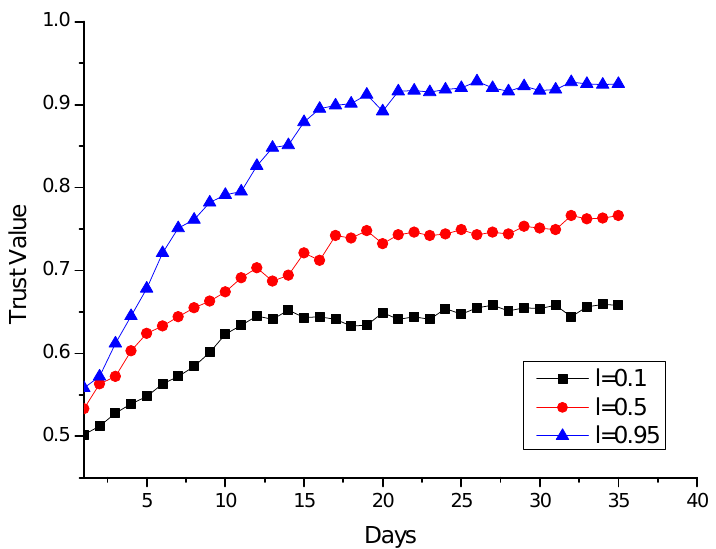
Figure 3. Convergence of trust values of intrusion detection system (IDS) nodes regarding three expertise